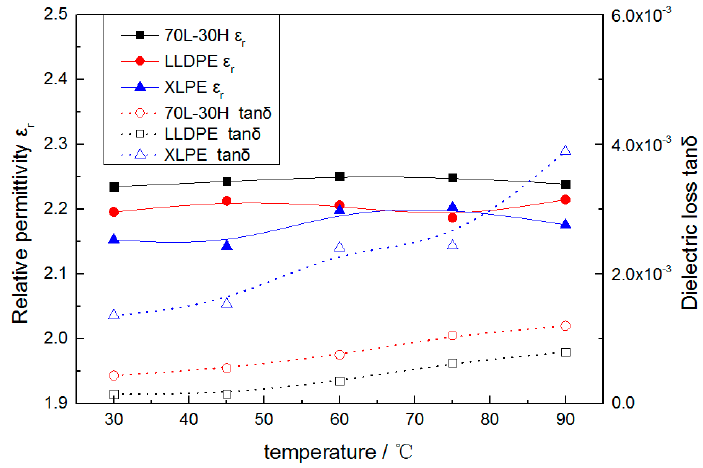
Figure 1. The relative permittivity and dielectric loss of 70 L-30 H, LLDPE and XLPE with temperature.